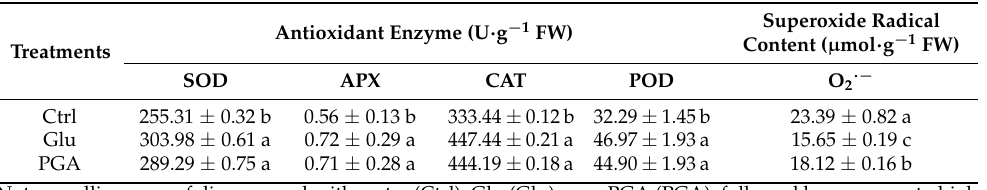
Table 2. Effect of Glu and γ -PGA on the antioxidant enzyme activity and superoxide radical produc- tion under heat stress.